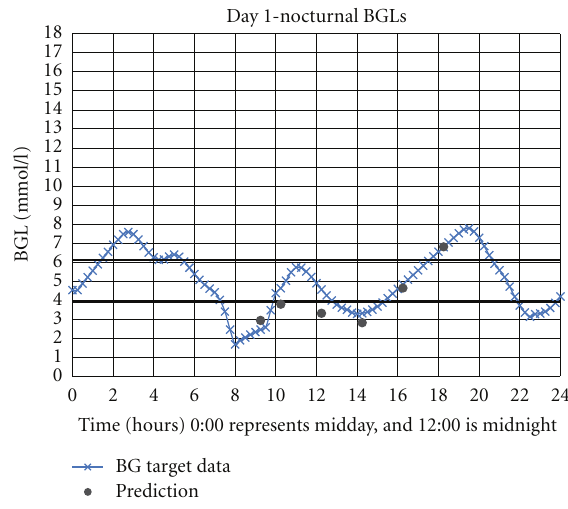
Figure 8: Predictions from trained ANNs on a test day which was not used during AIDA training. Each point represents a separate ANN, which was the best performing ANN over the 5 test days for a given prediction period.